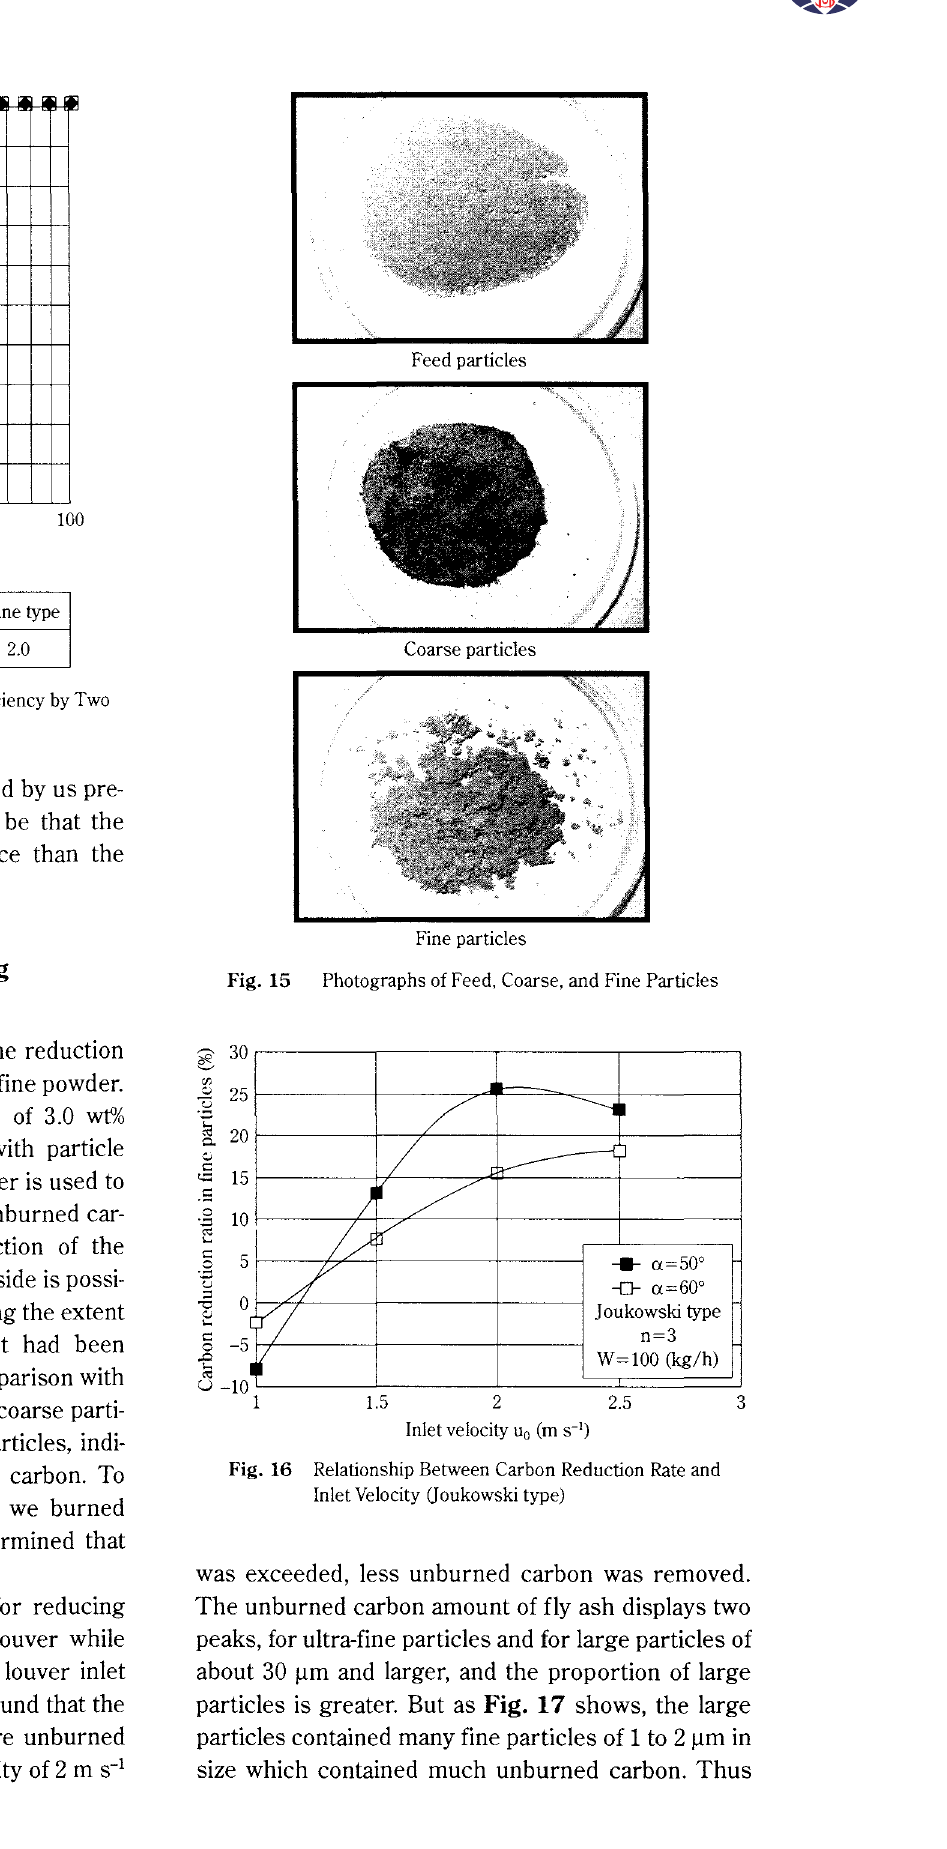
was exceeded, less unburned carbon was